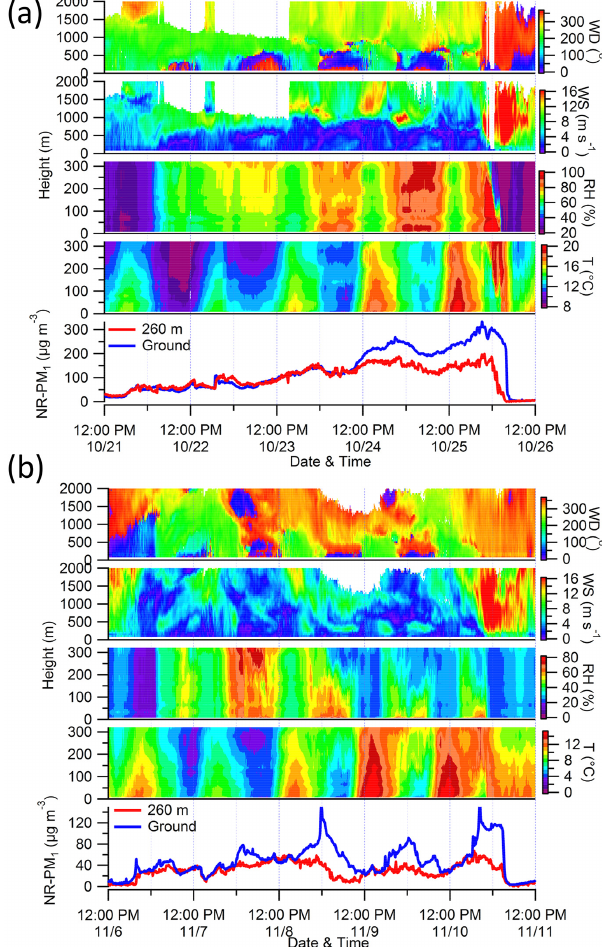
Figure 13. Evolution of vertical profiles of meteorological vari- ables (WD, WS, RH, and T ) and NR-PM 1 concentration at 260m and at the ground site during two pollution episodes (a) Ep2 and (b) APEC2. The vertical profiles of wind speed and wind direction were from the measurements of the Doppler wind lidar, and those of RH and T were from the tower measurements. The white areas in the figure indicate that the data were not